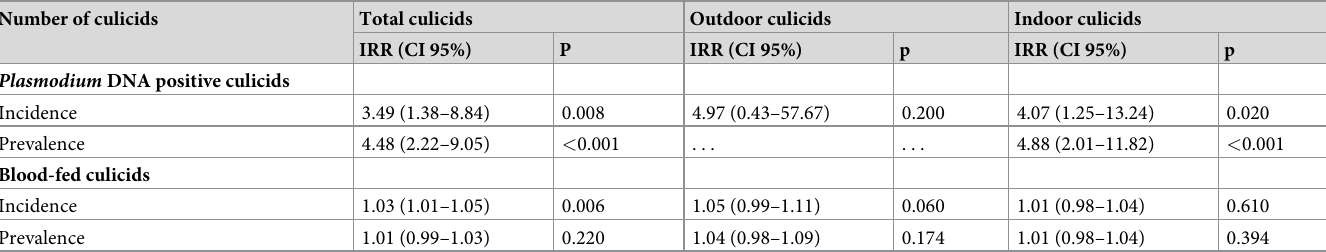
Table 5. Association of blood-fed and Plasmodium DNA positive culicids and force of infection and prevalence of malaria in the study